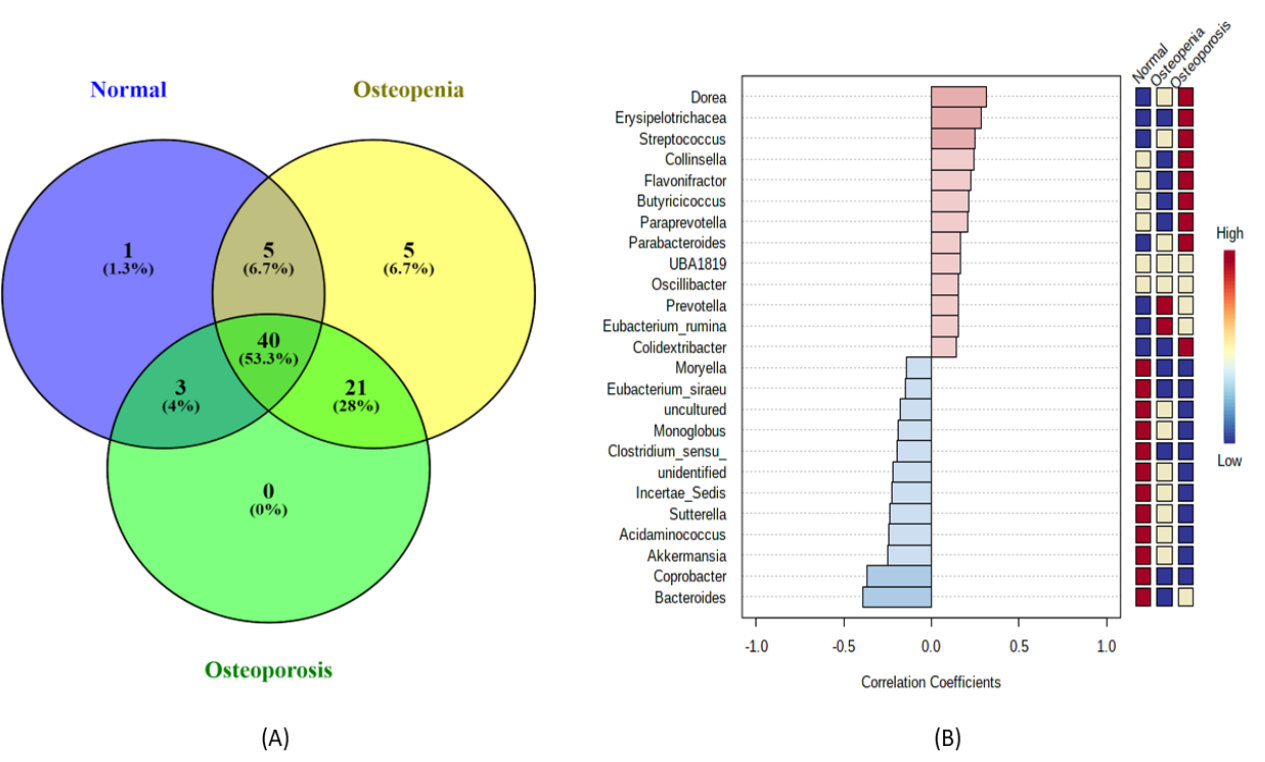
Figure 2. Comparison of bacterial community composition and abundance associated with experi- mental groups: normal control, osteopenia, and osteoporosis. Venn diagram ( A ) representing the shared and unique genera. Correlation analysis ( B ) showing the positive correlation (red bars) and negative correlation (blue bars) with a heatmap that denotes the pattern or shift of genus among the experimental